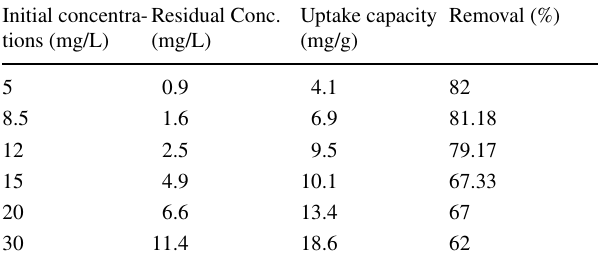
Fig. 5 Effect of contact time on Cr(VI) removal using 0.5 g/L of ACP-Zn and ACP-Zn-Fe at pH 2.0—2.5